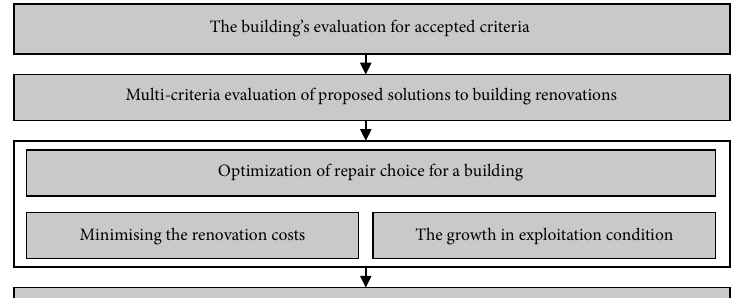
Fig.1. Stages of the proposed